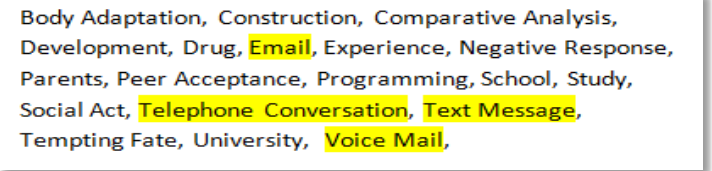
Figure 2: A sample set of codes generated from a qualitative